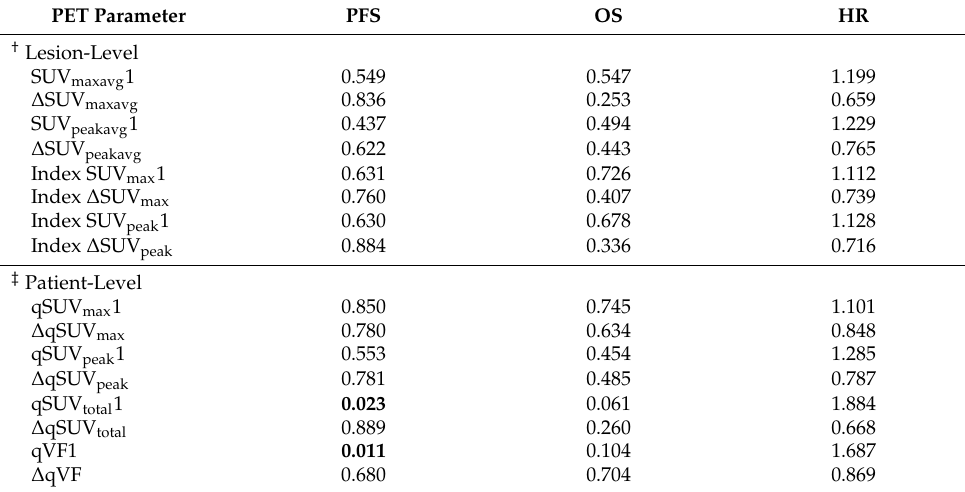
Table 3. Univariate analysis of PET variables to PFS and OS ( p -values, HR). PET Parameter PFS